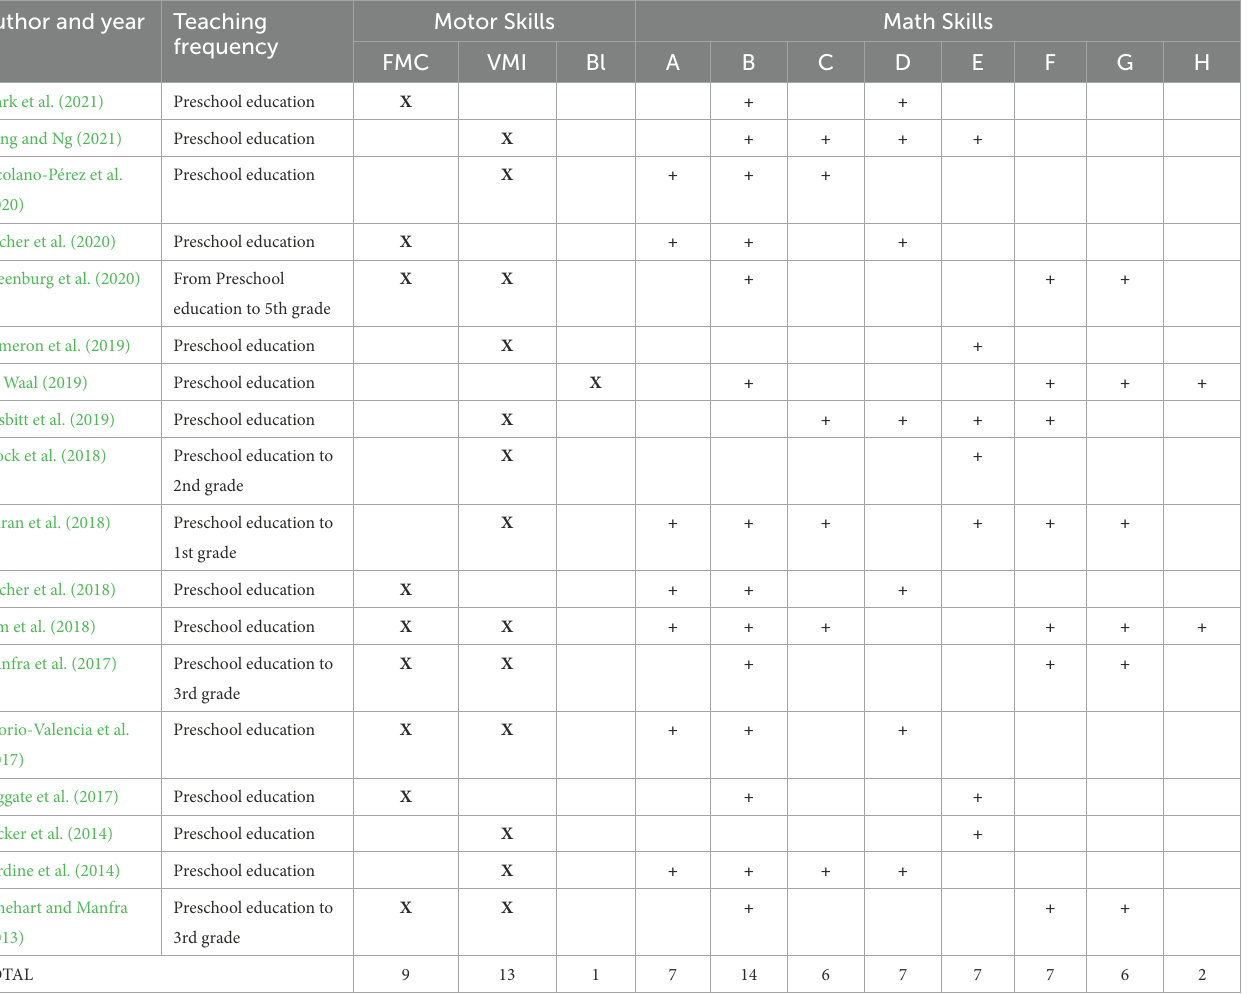
TABLE 3 Frequencies of associations between motor skills and mathematics by teaching